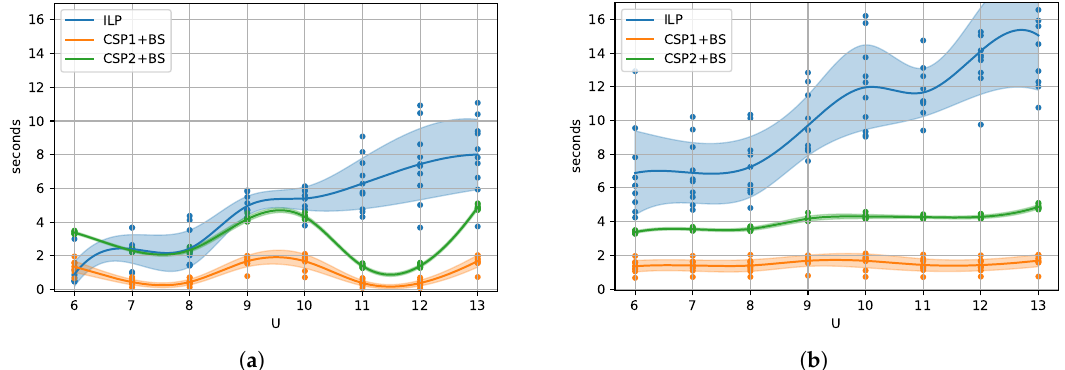
Figure 5. ( a ) Time to the optimal solution and ( b ) to proven optimality reported by Gurobi for the ILP, CSP1 + BS, and CSP2 + BS over 10 random graphs of order 100, p = 0.03, and b ( G ) = 6. The bounds are L = 1 and U ∈ [ b ( G ) , (cid:100) ( 4 · 100/3 ) 1/2 (cid:101) + 1 ] .